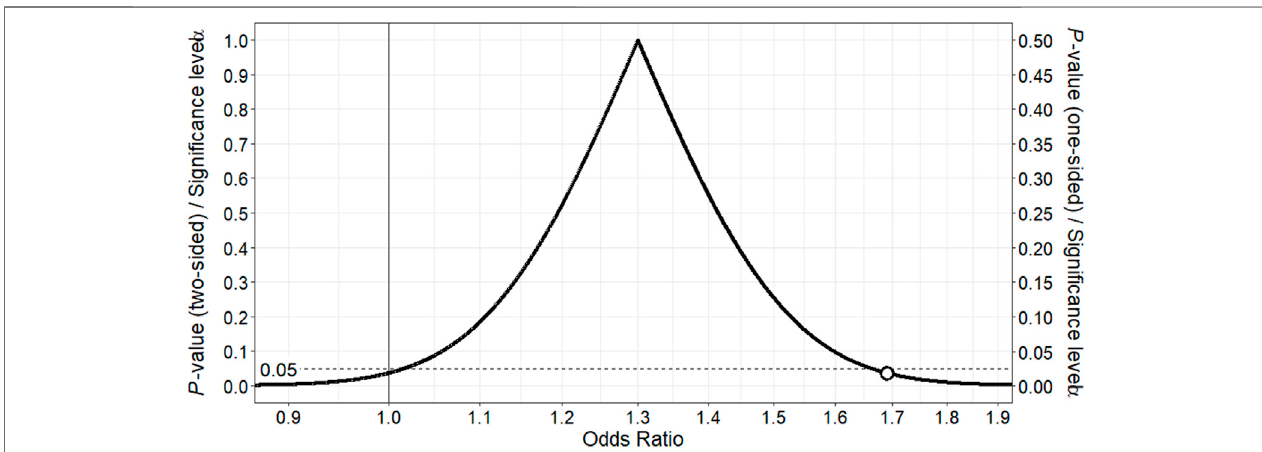
FIGURE 1 | p -value function for odds ratio for association between fl uvoxamine, paroxetine or sertraline and ventricular dysrhythmia or sudden death in methadone-treated patients. The point estimate of 1.30 corresponds to the peak of the p -value function. The vertical continuous line denotes the null value for the odds ratio, and the white point the counter-null value of 1.69, which is the effect size supported by the same amount of evidence as the null value.